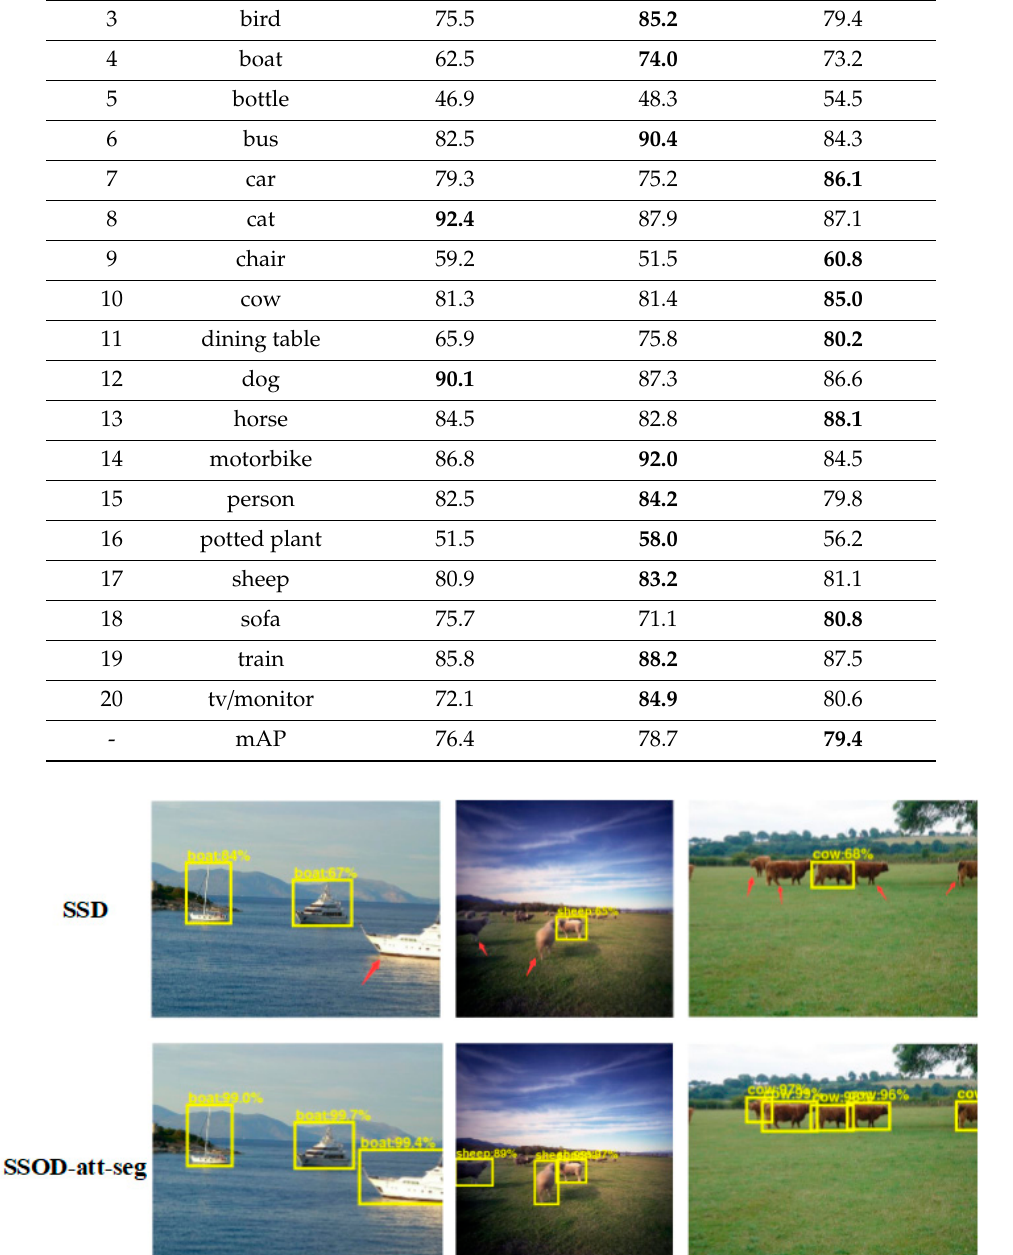
Figure 6. Comparison of detection effect between the SSOD-att-seg algorithm and SSOD-att algorithm. The arrows indicate the objects detected by the SSOD-att algorithm but missed by the SSOD-att-seg algorithm. The detection confidence of SSOD-att is higher and there are fewer undetected objects. Experiments have proved that the improved model using the multi-task learning idea can better detect the partially occluded objects in the images, and can be used for detection in some scenes with dense objects. By observing the pictures detected by the algorithm, it is also found that the SSOD-att algorithm is not accurate enough to detect objects, which is caused by the complex background at home, and the complex background may cause the false detection of the algorithm. Figure 7 shows the comparison of the detection results of the SSOD algorithm and the SSOD-att algorithm. The detection confidence of SSOD is higher and there are fewer undetected objects. The experiments proved that